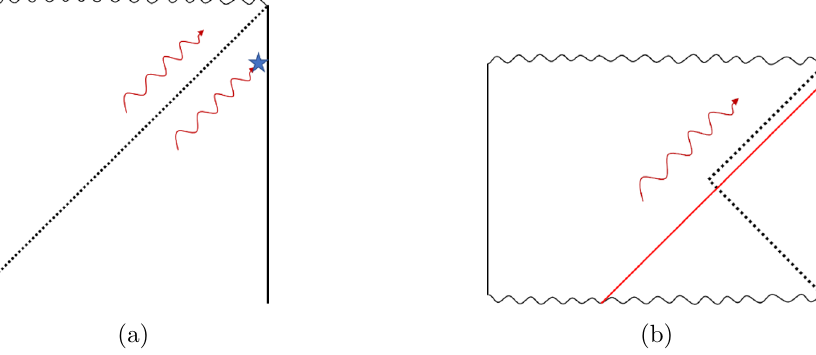
Figure 27 . (a) Penrose diagram for the spacetime of a one-sided black hole, with the Hawking radiation extracted and then measured. (b) If we reverse the time evolution after the measurement is done, the black hole won’t disappear as one might naively expect. Instead, at one scrambling time in the past, the backreaction from the measurement (shown in red as a small shockwave) will create a white hole. The interior partners of the Hawking radiation will therefore never escape from behind the